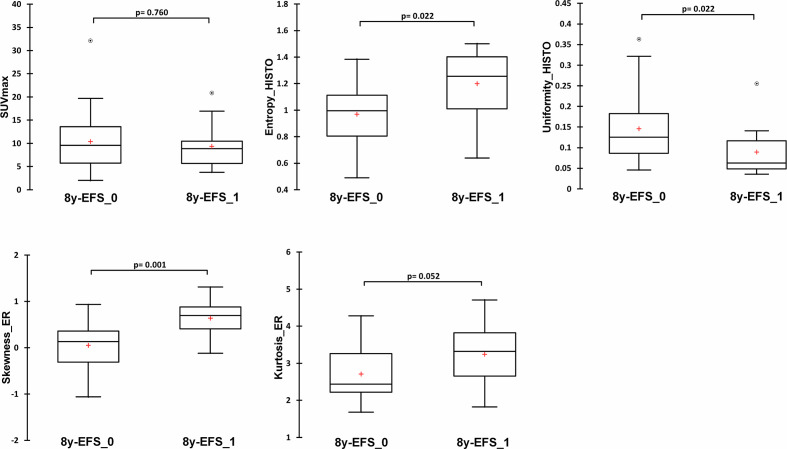
Comparison of immunochemistry and PET variables of importance identified by random forest analysis between 8y-EFS_0 and 8y-EFS_1 patients (SUVmax, entropy_HISTO, uniformity_HISTO, skewness_ER, and kurtosis_ER). Data are shown as Tukey boxplots with (○) representing outliers.